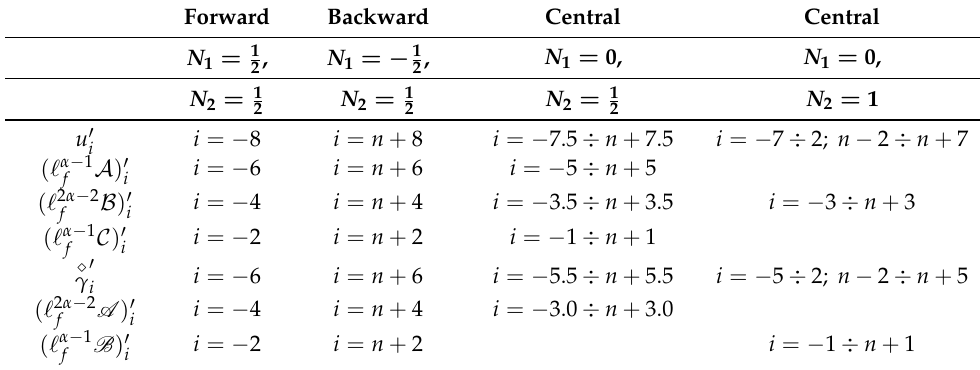
Table 1. The applied finite difference schemes in dependence on the position of discretization point i (see also Equation (28) and Figure